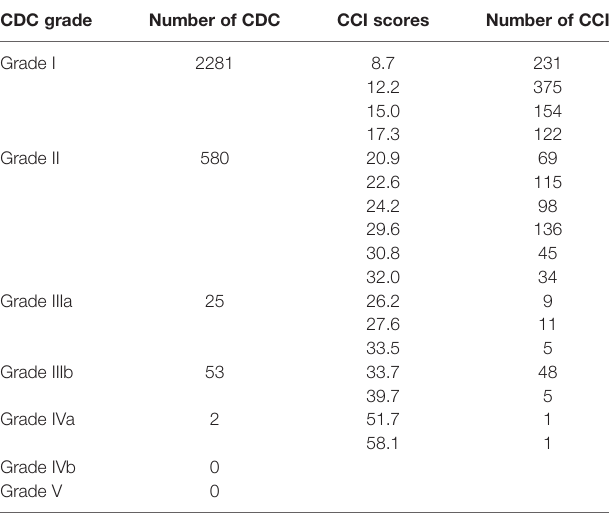
TABLE 5 | Complications analysis according to the CDC and the